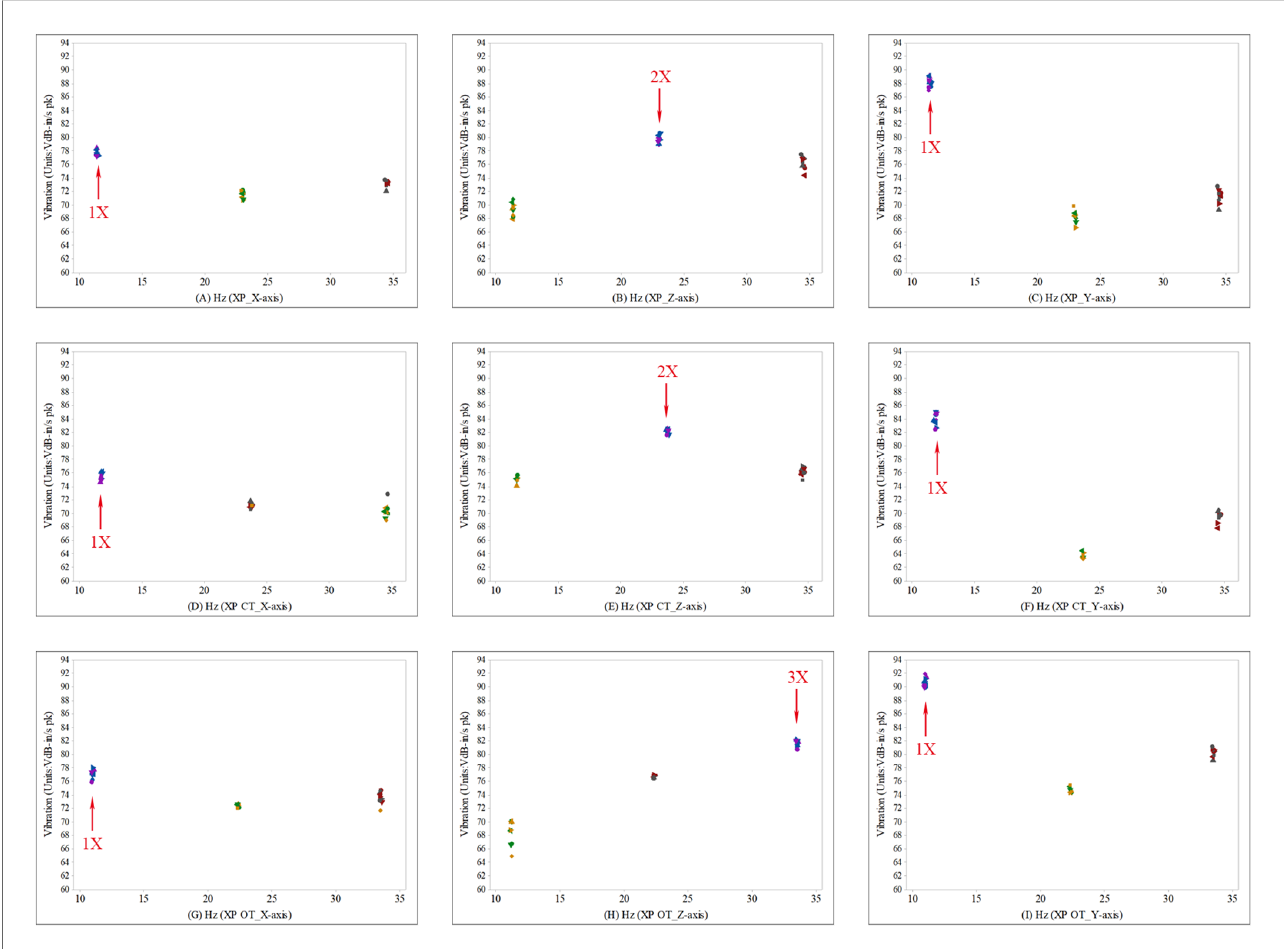
Figure 6. Results of the overall vibration measured in the X-, Z-, and Y-axis directions.